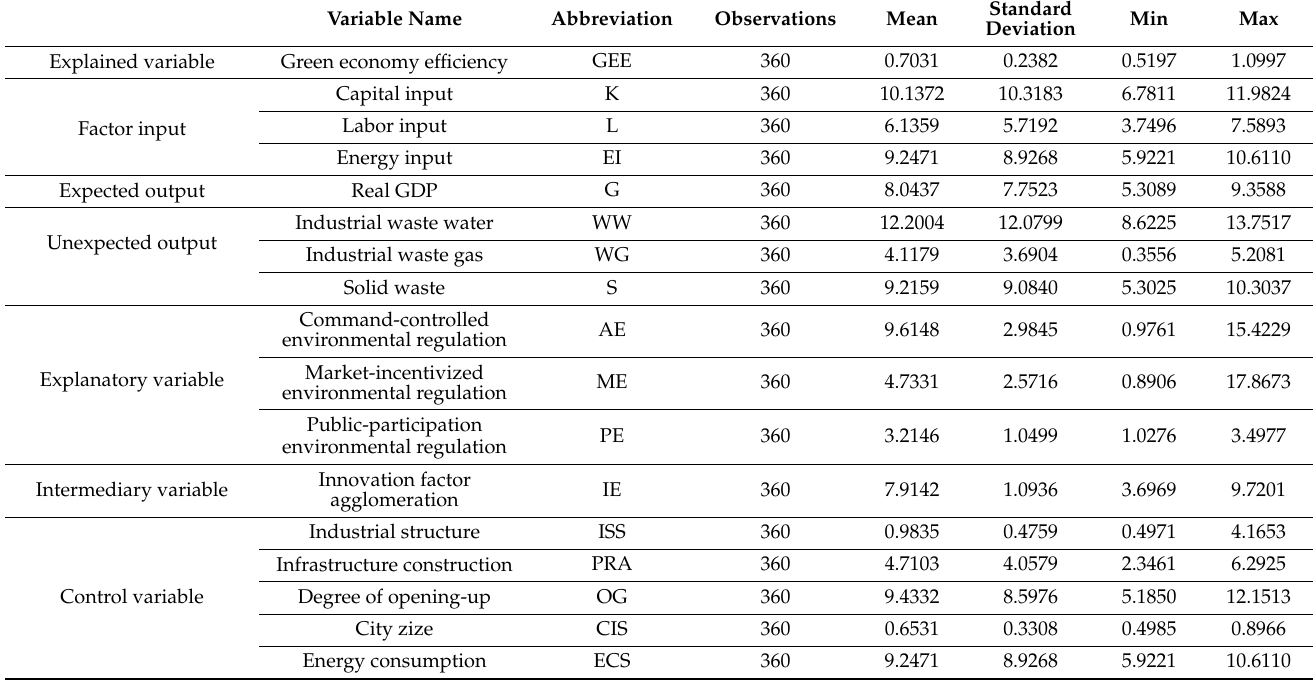
Table 1. Definitions of